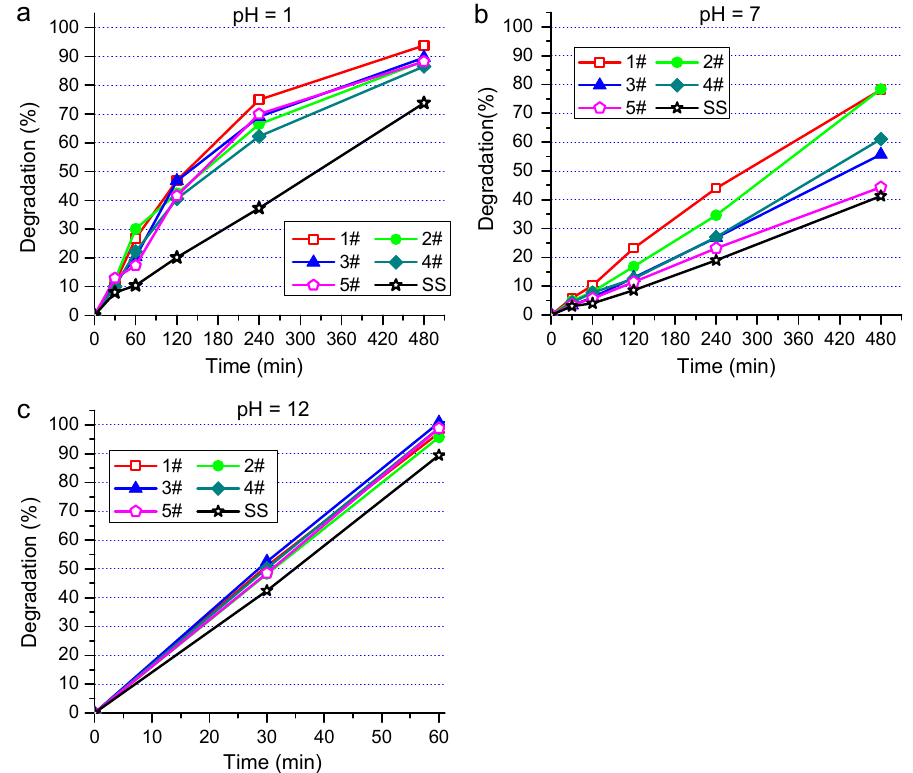
Figure 4. The MO solution degradation rates at different pH values—( a ) pH = 1, ( b ) pH = 7 and ( c ) pH = 12— under irradiation by ultraviolet light.